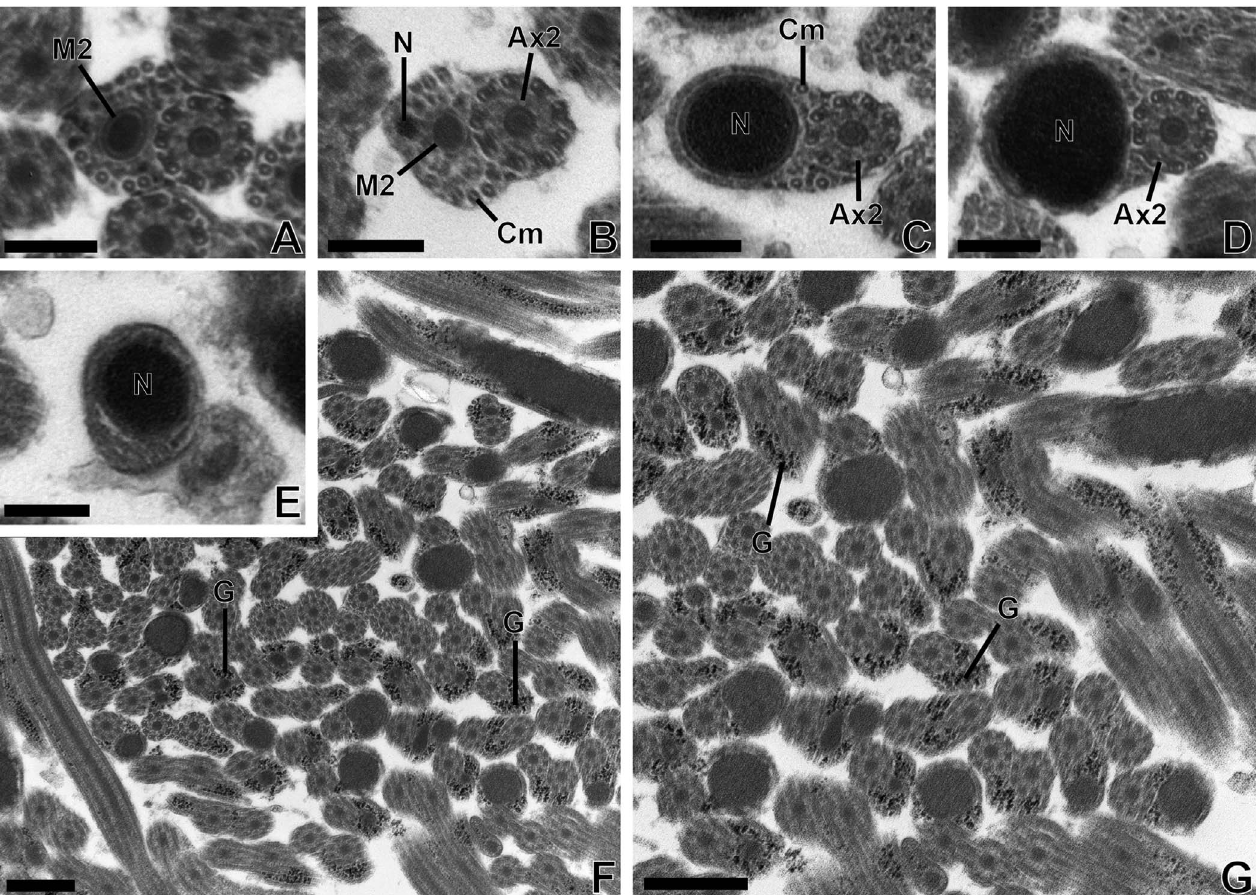
Figure 2. (A – E) Transmission electron micrographs of region IV (posterior region) of the mature spermatozoon of Tergestia clonacantha. Scale bars = 0.2 l m. Cross-sections in region IV of mature spermatozoon of Tergestia clonacantha showing the appearance of the second mitochondrion (M2) (A), then the nucleus (N) (B). (C) Cross-sections showing the disappearance of the fi rst mitochondrion, a progressive disappearance of microtubules (C – D) and axoneme 2 (E). Then, the posterior extremity of the spermatozoon exhibiting only the nucleus (E). (F – G) Transmission electron micrographs showing many sections of the mature spermatozoon of Tergestia clonacantha with granules of glycogen (G) highlighted by the Thiéry method. Scale bars = 0.5 l